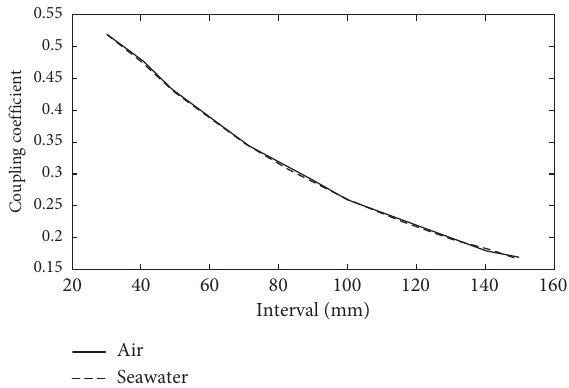
Figure 14: Comparison of coupling coefficients between air and seawater.